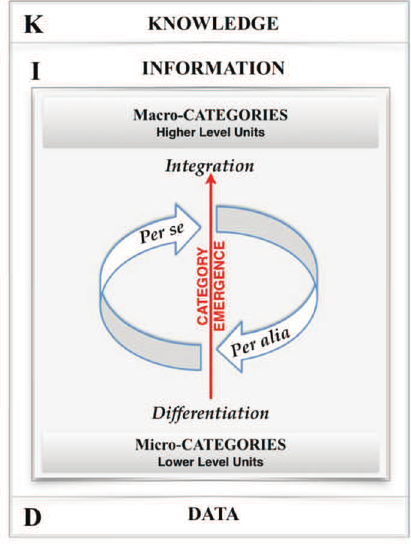
Figure 2. Information as the result of two kinds of processes (conceptualisation and categorisation) passing through multiple layers of its emergence from data to